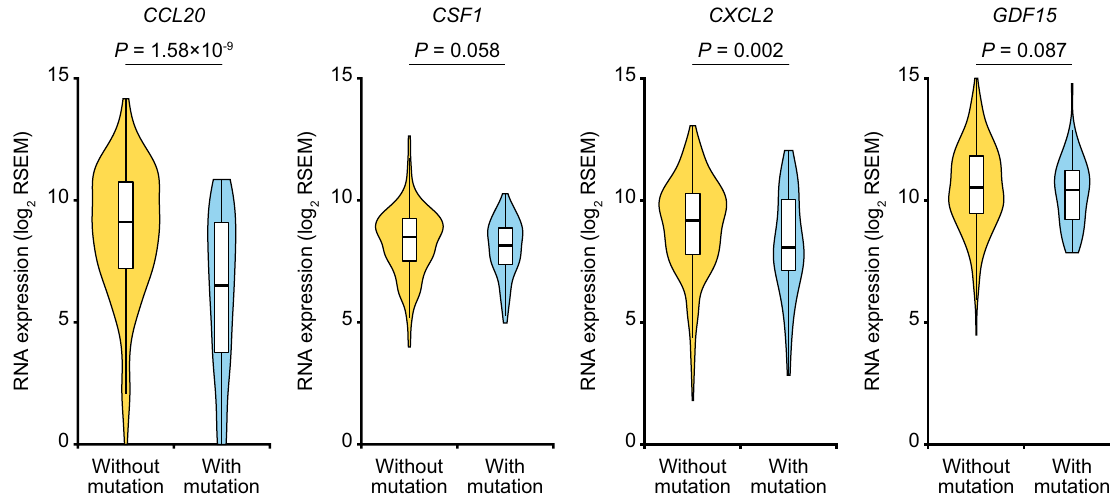
Figure 5. Downregulation of cytokines in human HCC samples with CTNNB1 hotspot mutations. Boxes in violin plots represent the interquartile range (range from the 25th to the 75th percentile), and horizontal lines show the median values. P -values were calculated by Mann–Whitney U